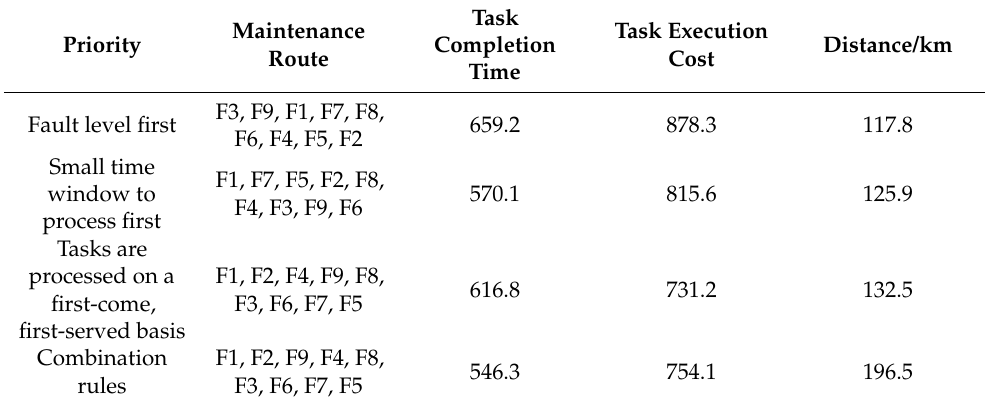
Table 7. Average metrics for solving rules with different